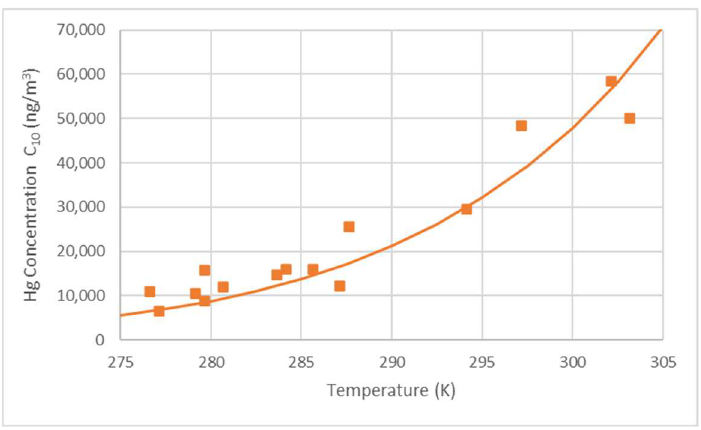
Figure 12. Hg concentration C 10 vs. temperature; measured (dots) and calculated with evaporation liquid model (line).